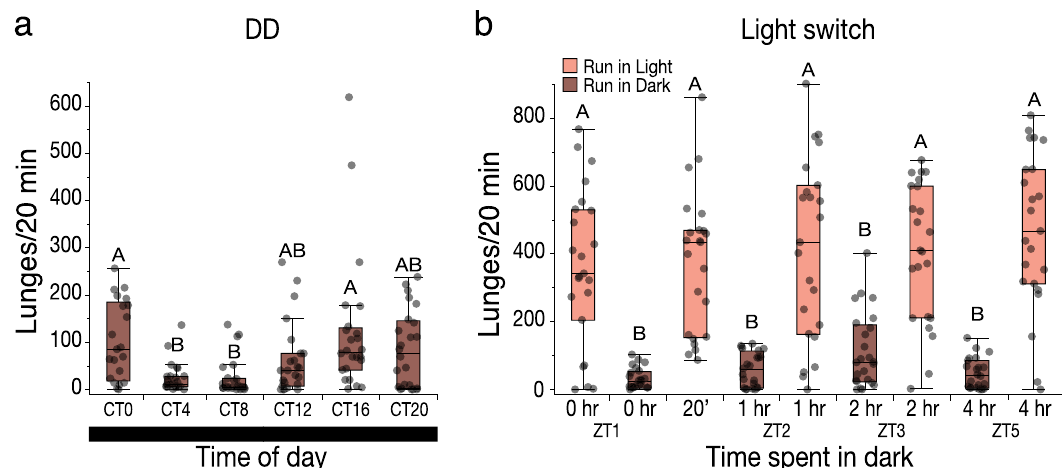
Fig. 7 Aggression under free-running conditions compared to the effect lights “ ON ” and “ OFF ” . a Lunge number variations of the hyper-aggressive strain at different times of the day under free-running DD conditions (Kruskal – Wallis ANOVA with Dunn ’ s test and Bonferroni correction, CT0 vs. CT8, p = 0.0024; CT0 vs. CT4, p = 0.033; CT16 vs. CT8, p = 0.0009; CT16 vs. CT4, p = 0.0154; CT20 vs. CT4, p = 0.0983; CT12 vs. CT4, p = 0.5288; CT20 vs. CT4, p = 0.7187, n = 20 – 24 pairs per time point). b Lunge numbers in fl ies that are run in light vs. dark at the beginning of the day signi fi cantly decrease strongly compared to fl ies run in light and fl ies kept in dark for 20 min and are then run in light (Kruskal – Wallis ANOVA with Dunn ’ s test and Bonferroni correction, ZT1 0L vs. ZT1 0D , p < 0.0001; ZT1 0L vs. ZT1 20 ′ L , p = 1.000; ZT1 0D vs. ZT1 20 ′ L , p < 0.0001, n = 24 pairs per time point). Increasing the dark treatment duration does not signi fi cantly increase lunge numbers of dark tested (Kruskal – Wallis ANOVA with Dunn ’ s test and Bonferroni correction, all dark comparisons, p = 1.000, n = 24 pairs per time point). Dark treatment followed by testing the fl ies in light leads to fully recovered lunge numbers (Kruskal – Wallis ANOVA with Dunn ’ s test and Bonferroni correction, all light comparisons, p = 1.000, n = 23 – 24 pairs per time point). Boxplots show the median, fi rst and third quartiles as boxes, with whiskers representing the 5 and 95%